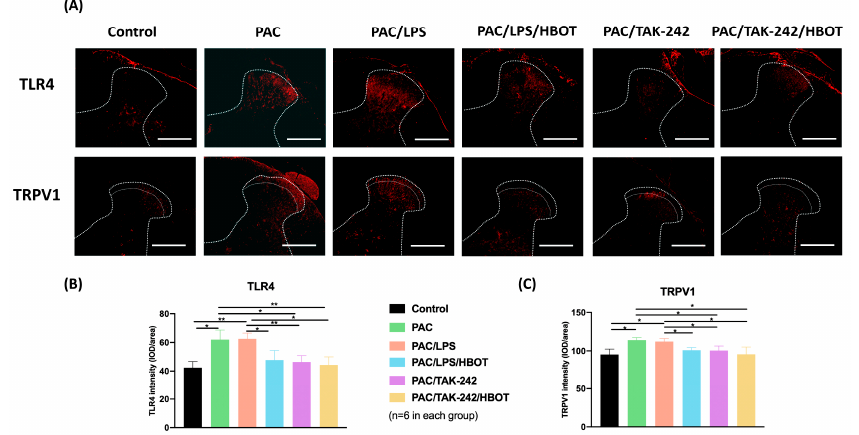
Figure 3. Expression of TLR4 and TRPV1 in the rat spinal cord dorsal horn. ( A ) IF image indicating TLR4 and TRPV1 antibody staining of the L3–5 spinal cord from the control, PAC, PAC/LPS, PAC/LPS/HBOT, PAC/TAK-242 and PAC/TAK-242/HBOT groups. Scale bar = 200 μ m. ( B ) Bar graphs showing the intensity of TLR4 antibody staining. ( C ) Bar graphs showing the intensity of TRPV1 antibody staining. Data are expressed as mean ± standard error of the mean (SEM) ( n = 6 per group). * p < 0.05, ** p < 0.01.